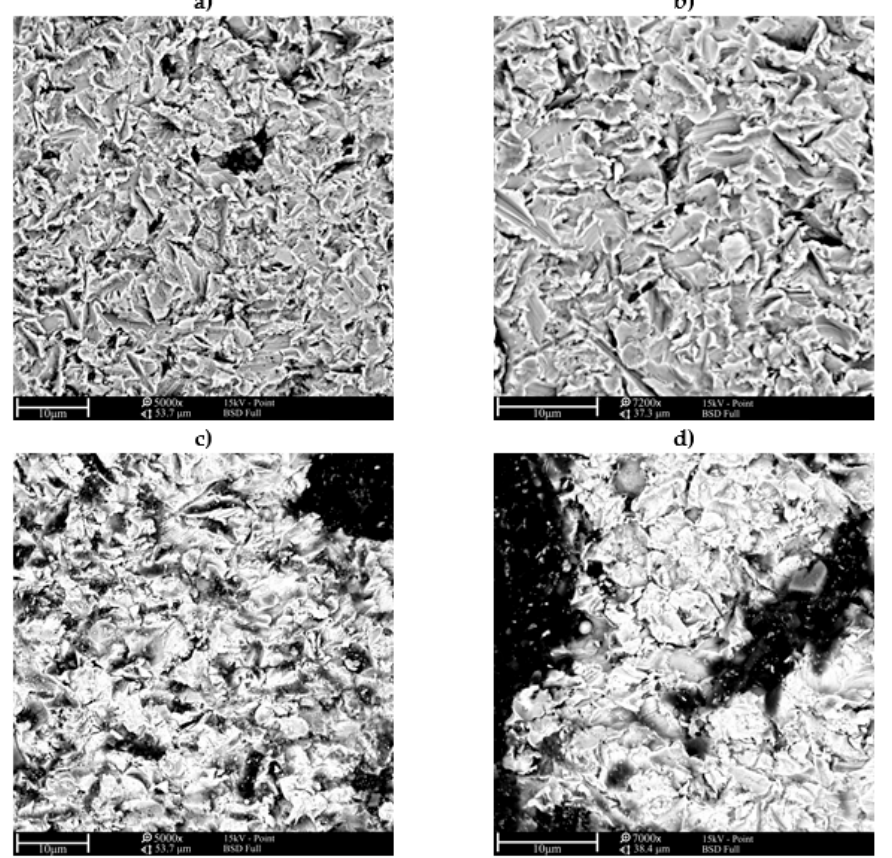
Figure 11. The SEM micrographs of worn surfaces after erosive tests with the impingement angle 30°; ( a , b ) representative surface layer; ( c , d ) reference material EN GJS 350-22.